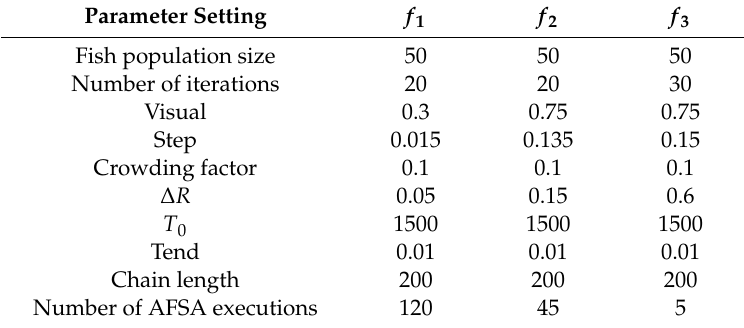
Table 1. Parameters setting of improved artificial fish swarm algorithm (IAFSA) corresponding to the test functions.